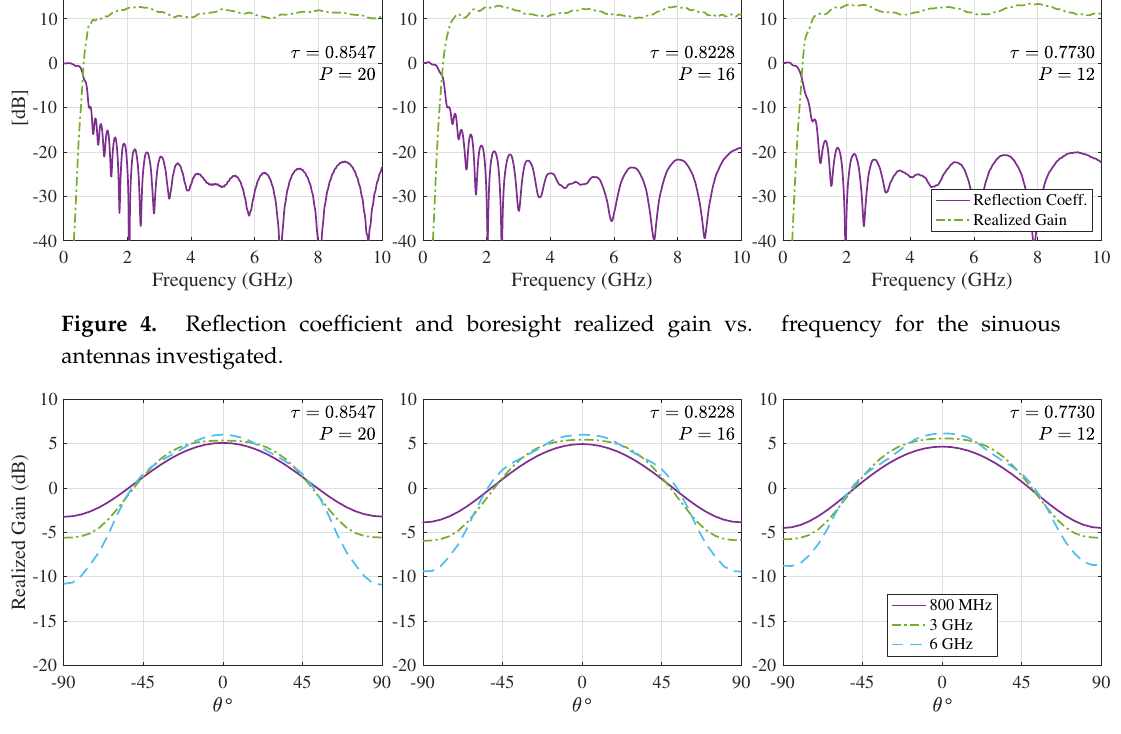
Figure 5. Principle E-plane pattern cuts at 800 MHz, 3 GHz, and 5 GHz for the sinuous antennas